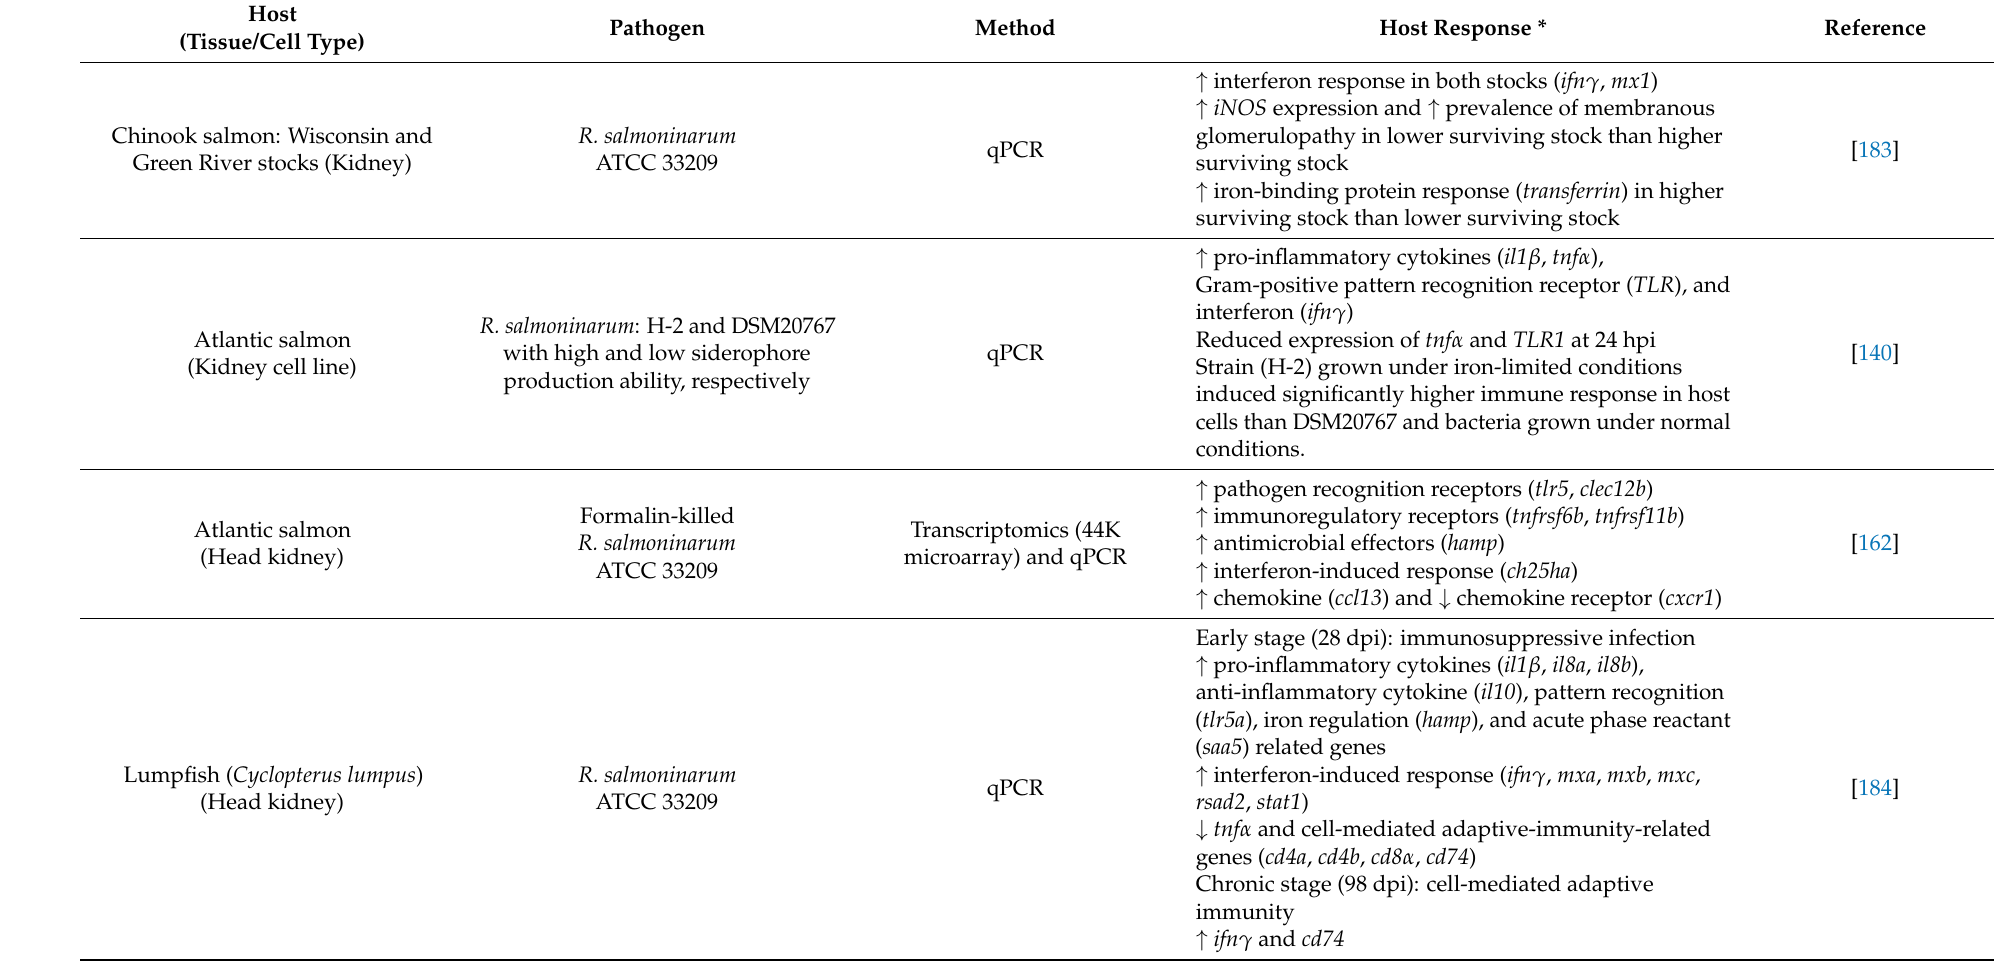
Table 2. Recent studies on host (fish) response to marine Gram-positive bacterial